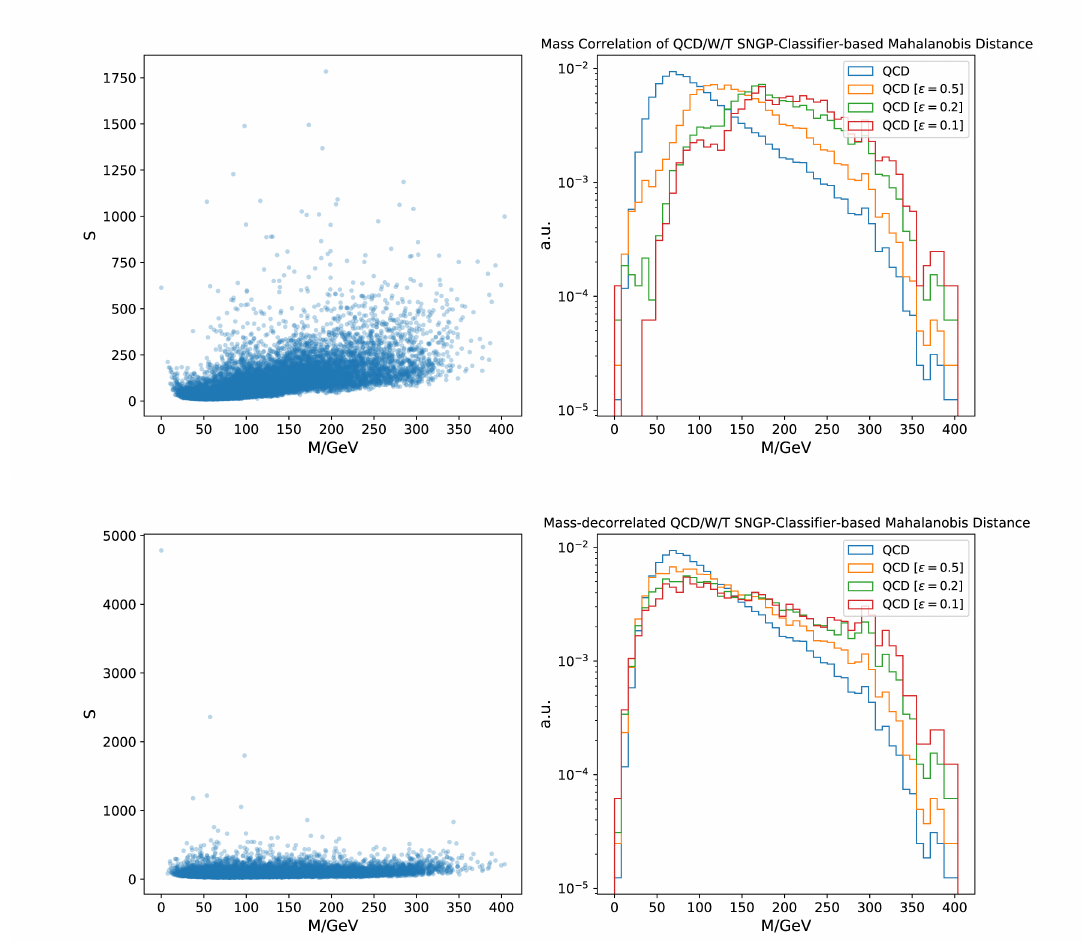
Figure 14 . SNGP Model. Top : The un-decorrelated model with the Mahalanobis distance as the anomaly score. Bottom : The mass-decorrelated model with the Mahalanobis distance as the anomaly score. Left : The correlation between jet mass M and the anomaly score. Right : Mass distributions for different background acceptance rates ( (cid:15)